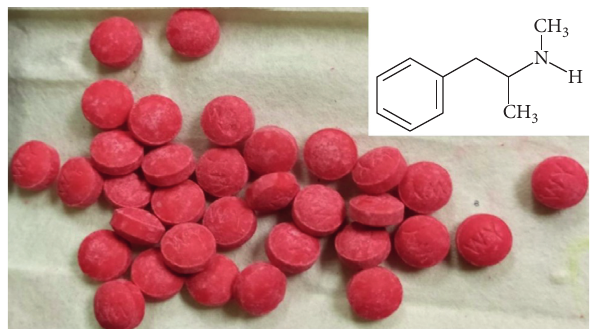
Figure 1: Sample of methamphetamine in